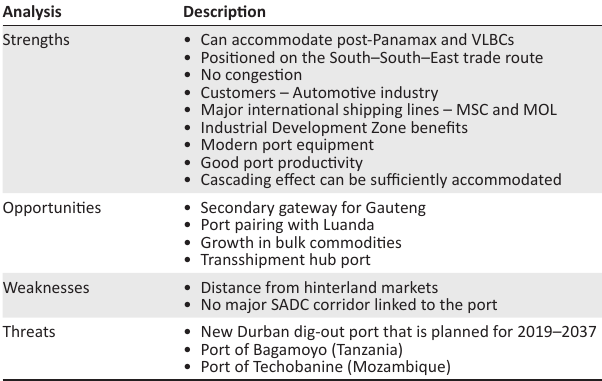
TABLE 5: Strengths, weaknesses, opportunities and threats analysis of Ngqura port and its hinterland.